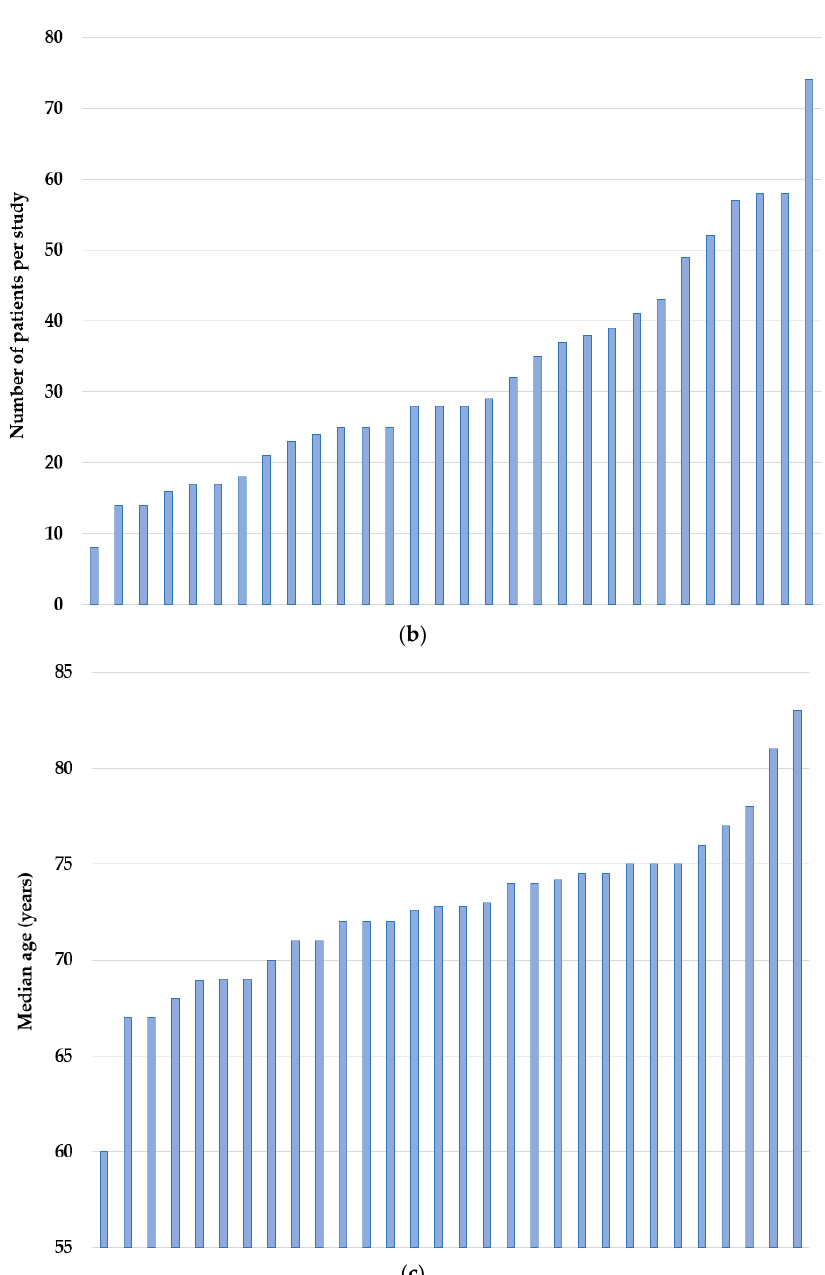
Figure 2. ( a ) Number of LDMC publications per year. ( b ) Number of patients per study. ( c ) Median patient age in years per study.